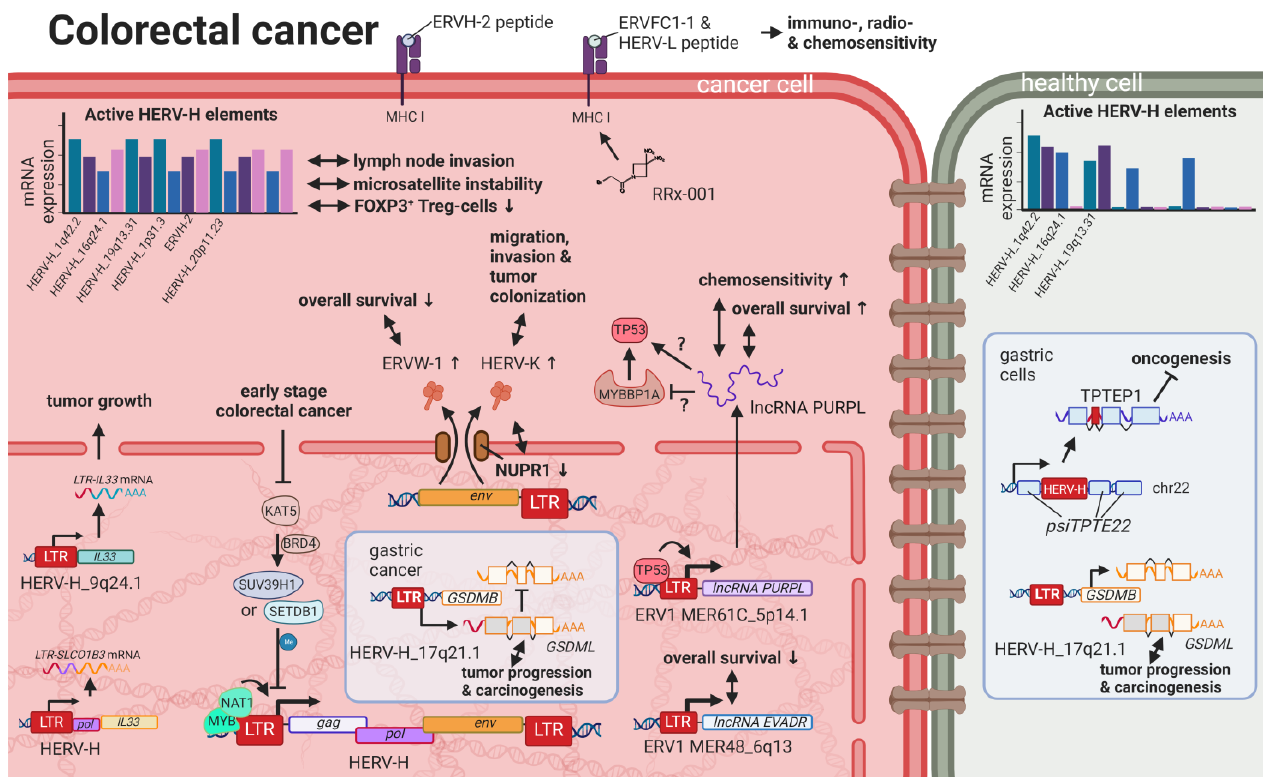
Figure 6. The role of HERVs in colorectal cancer. Evaluated treatments are marked in red. Abbrevi- ations: lncRNA = long non-coding RNA, LTR = long terminal repeat, gag = group antigen (capsid), pol = polymerase, env = envelope, HERV-K = HML-2.